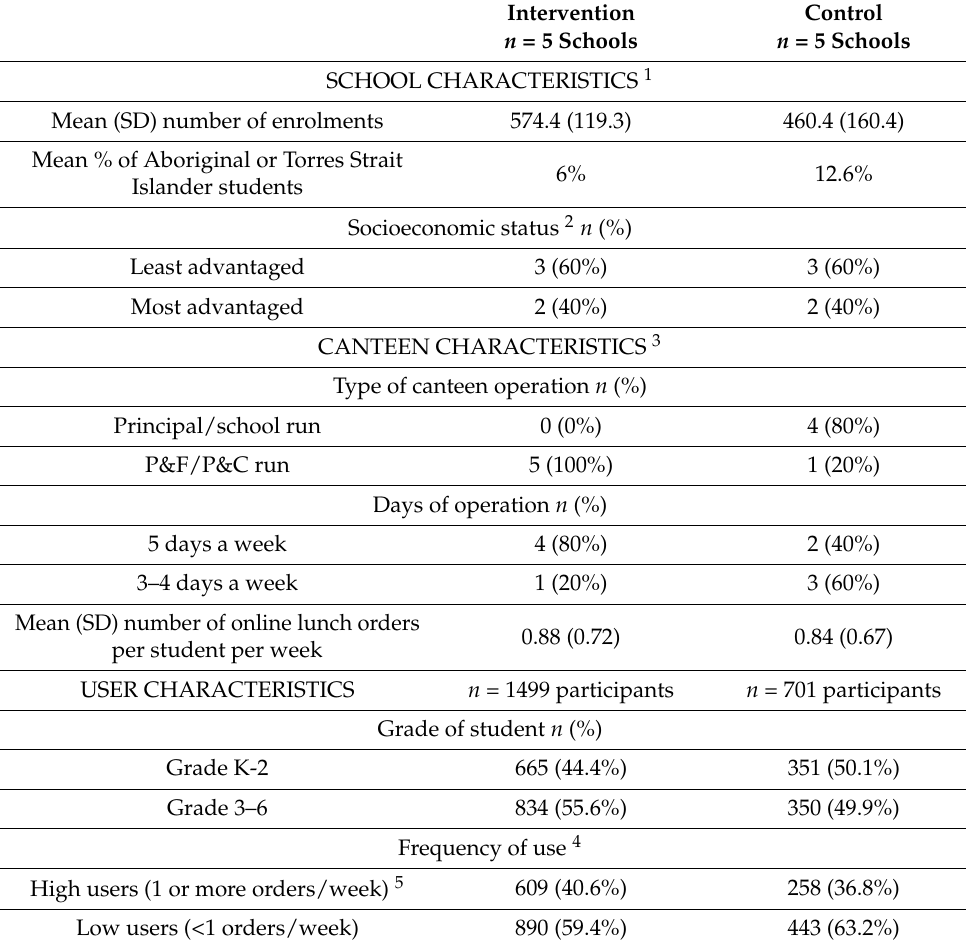
Table 1. Characteristics of the